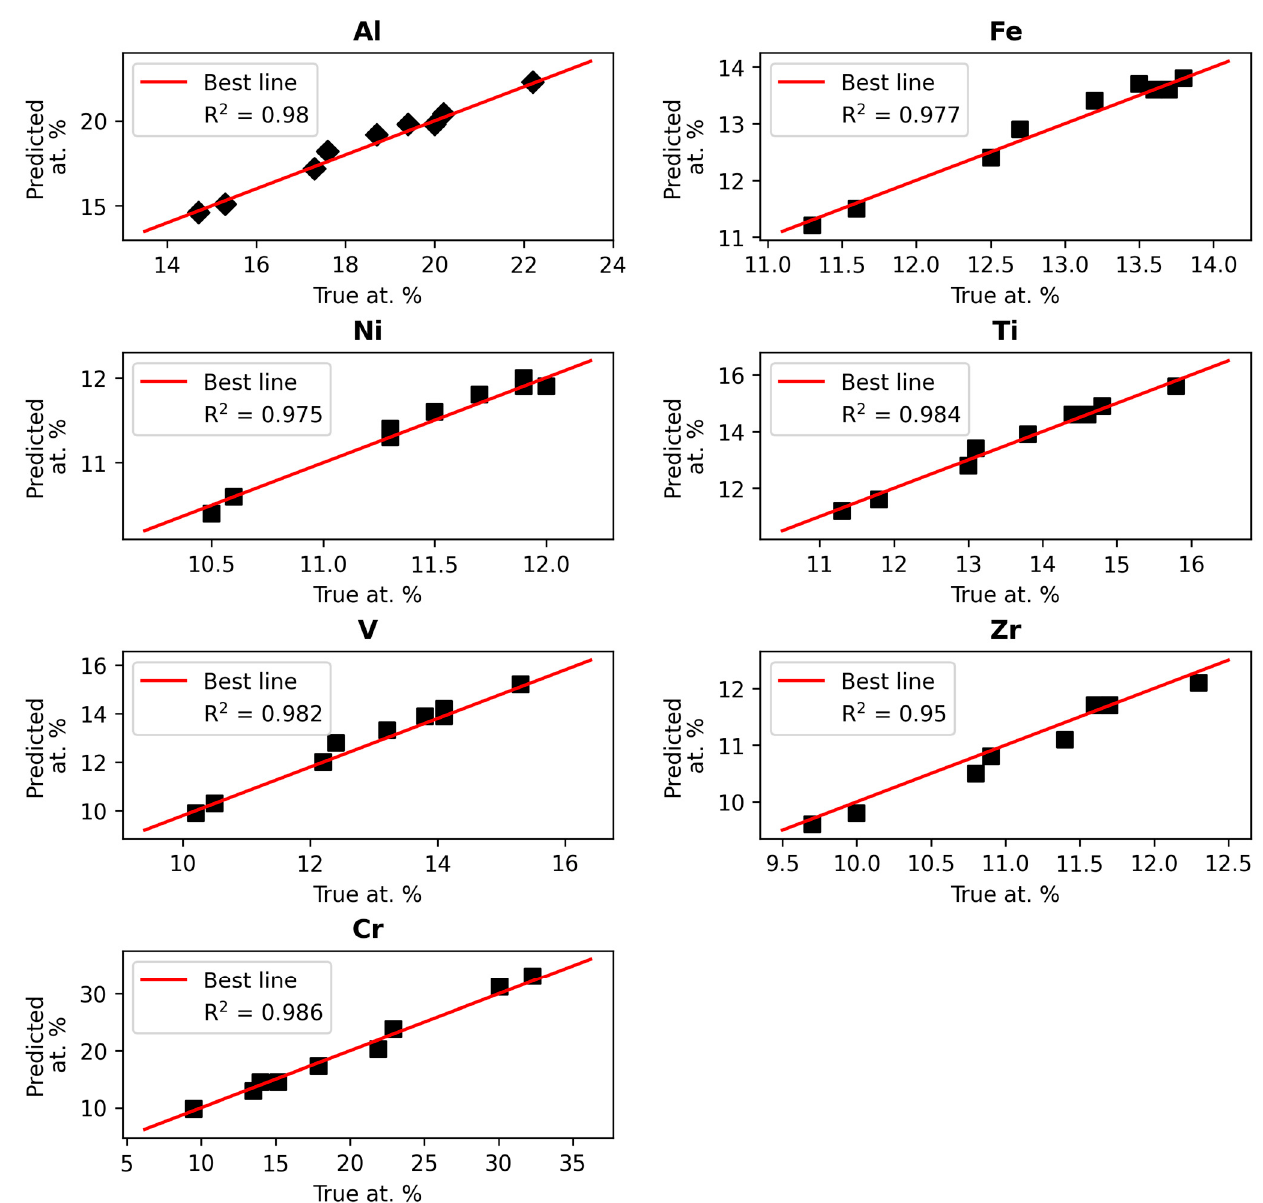
Figure 4. True and predicted values of elements’ atomic percentage computed by the decision tree model.